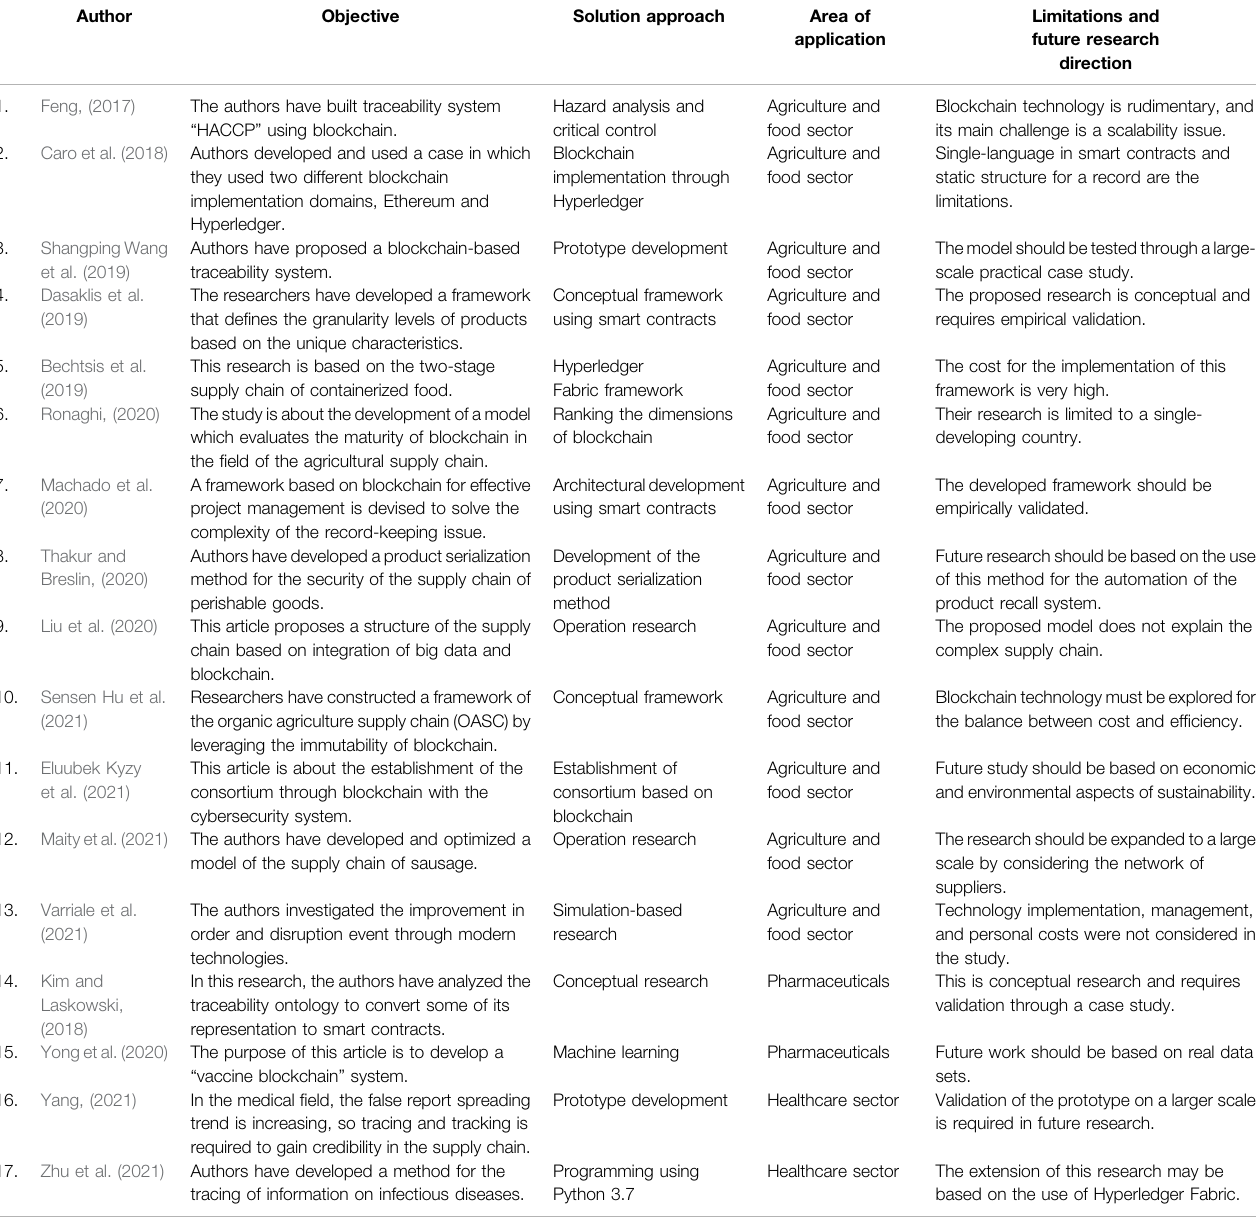
TABLE 1 | Models and framework development for the blockchain-based supply chain with economic sustainability in the agriculture, food, and healthcare